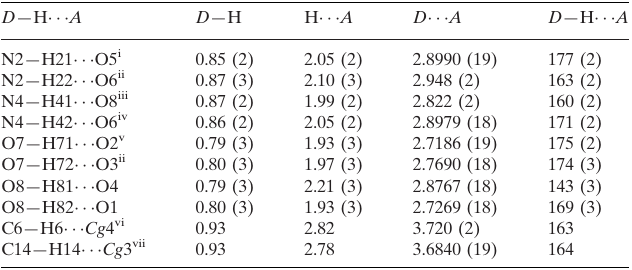
Hydrogen-bond geometry (A˚ , (cid:3)